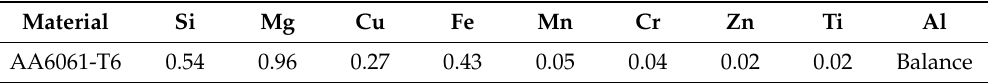
Table 1. Nominal chemical composition of materials used in FSW experiments (wt. %).